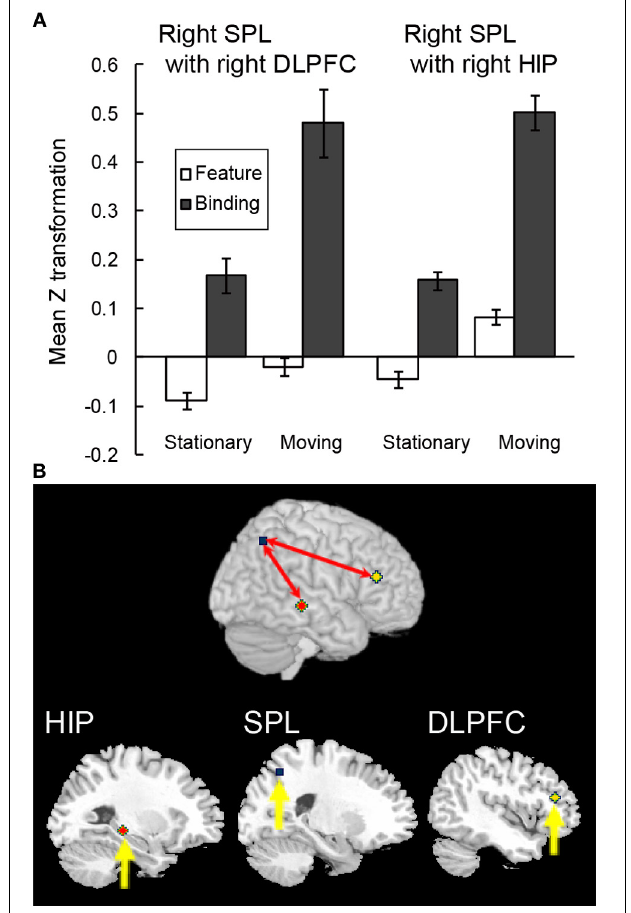
FIGURE 6 | Functional connectivity during the maintenance of complex feature-location binding. (A) Functional connectivity between regions is plotted as the mean z score transformation of the beta-series correlations during the maintenance of task-relevant feature-location binding. The error bars represent s.e.m. (B) A schematic of the complex feature-location binding network; network regions include the right hippocampus (MNI coordinates: 30, − 30, − 4; yellow cluster), the right infPreCS (MNI coordinates: 52, 2, − 32; blue cluster), and the right DLPFC (MNI coordinates: 48, 40, 14; red cluster).